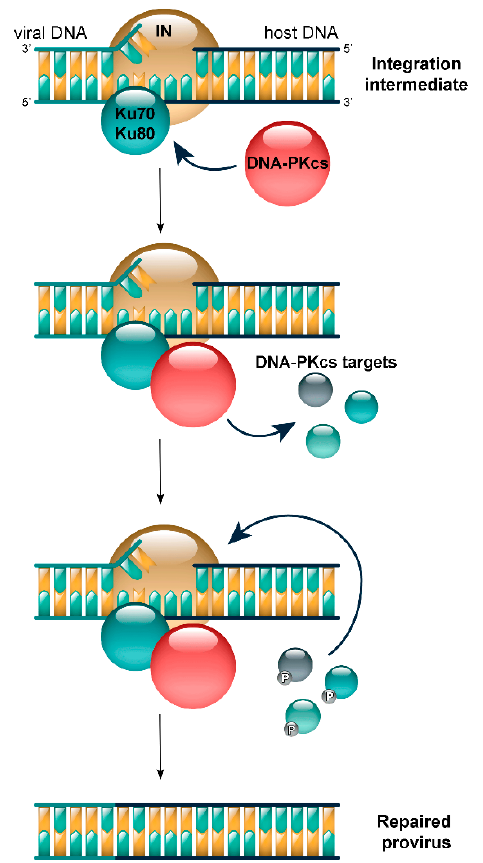
Figure 1. Model of HIV-1 post-integrational DNA repair based on our previously published data [10]. HIV-1 integrase (IN) that marks integration sites recruits the Ku70/Ku80 heterodimer by direct interaction with the Ku70 subunit; then, the catalytic subunit of DNA-PK (DNA-PKcs) binds to this complex and phosphorylates some unknown protein targets that results in DNA repair. This process strongly depends on the interaction between IN and Ku70.